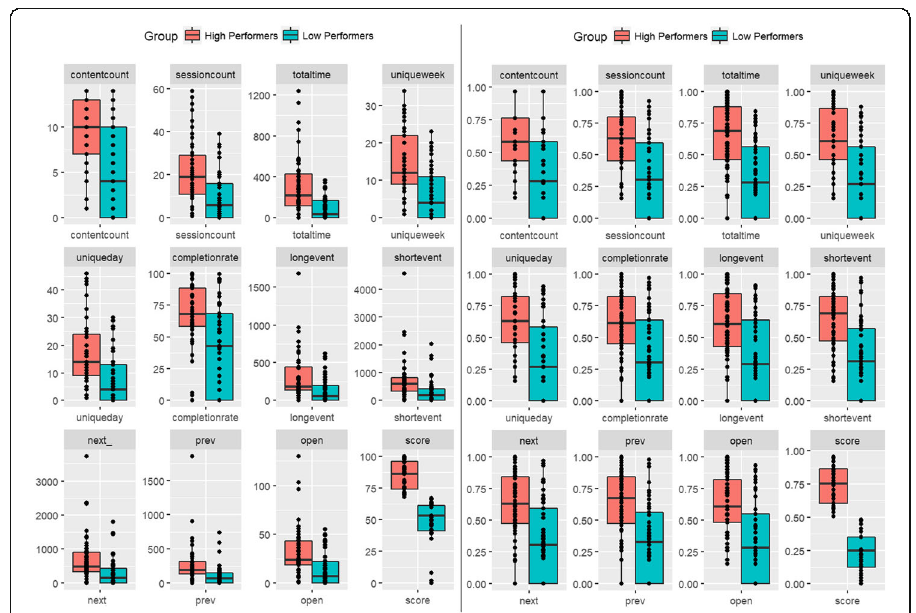
Fig. 3 Distribution of raw data (left) and transformed data